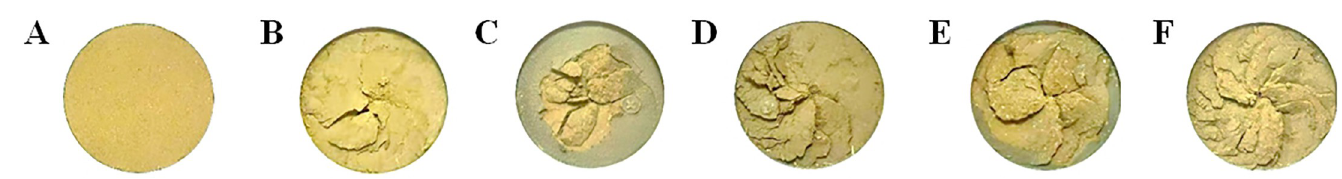
Fig 15. Comparison of the shear surface morphology of 22 # , 25 # - 28 # remolded loess specimen before and after the test shearing ( w = 16%). (A) Before specimen. (B) 25 # σ = 100 kPa. (C) 26 # σ = 200 kPa. (D) 27 # σ = 400 kPa. (E) 22 # σ = 800 kPa. (F) 28 # σ = 1200 kPa.